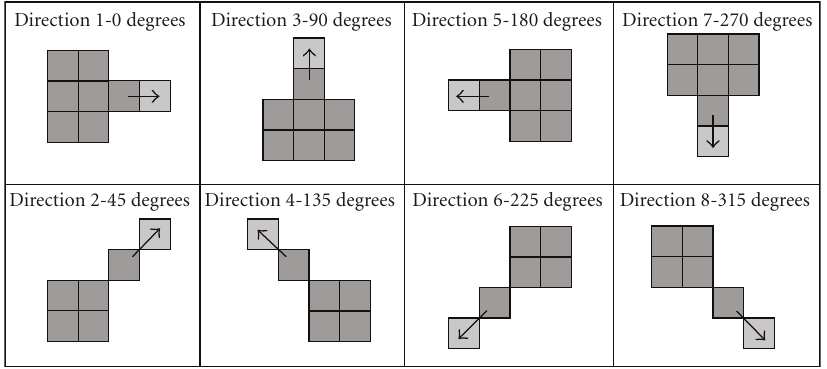
Figure 4: The pixel groups belonging to each of the possible eight directions. The arrow points to the central pixel of the 7 × 7 matrix, and shows the direction of the pixels from the previous frame to the current